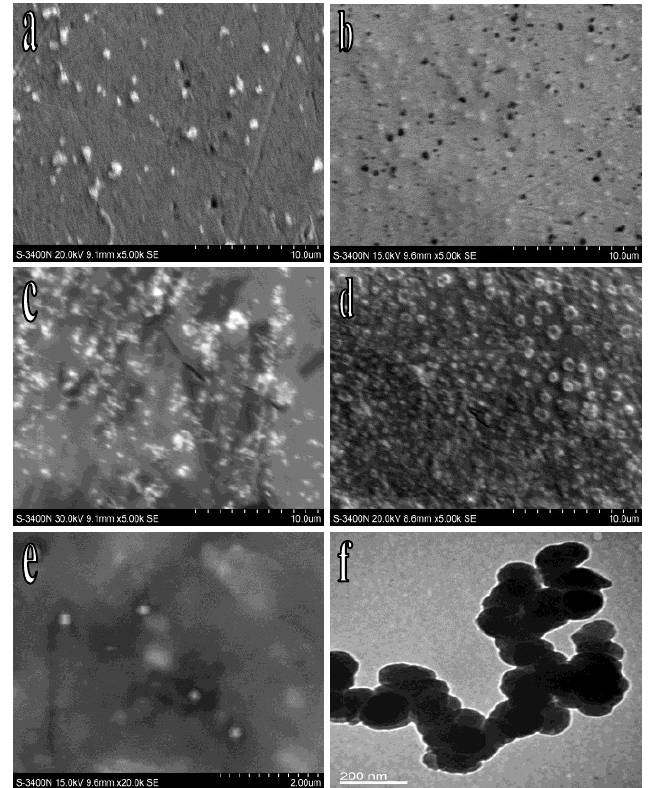
Figure 2. Characterization of the nanomaterials by SEM and TEM. SEM of AuNP ( a